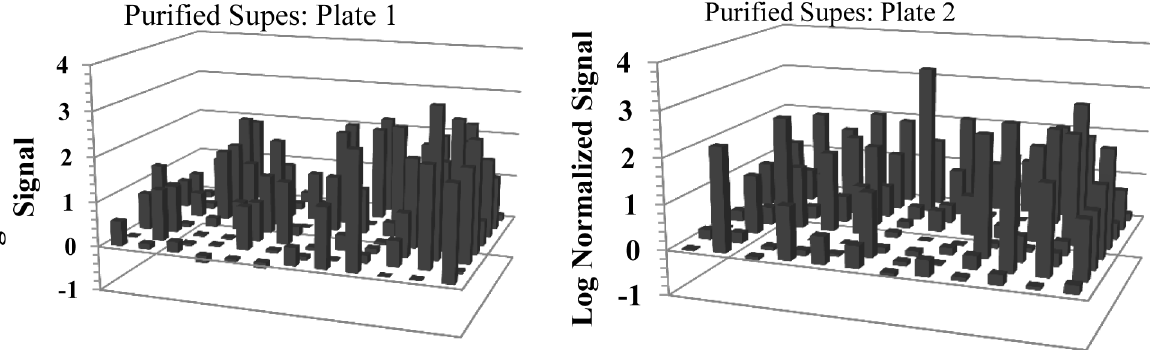
Fig 6. Approximately half of the hybridomas retain M Φ binding following expansion and purification. Supernatants from hybridomas that were expanded and purified were screened on IFN- γ treated M Φ ’ s using MSD as the readout. All 700 hybridomas were tested, shown above is representative data from two 96-well plates. Histograms are laid out in a 96-well plate format such that the X-axis represents the column numbers and the Z-axis represents the row identities. Each sample was run as a single replicate and log transformed signal (cid:1) 0.5 was considered